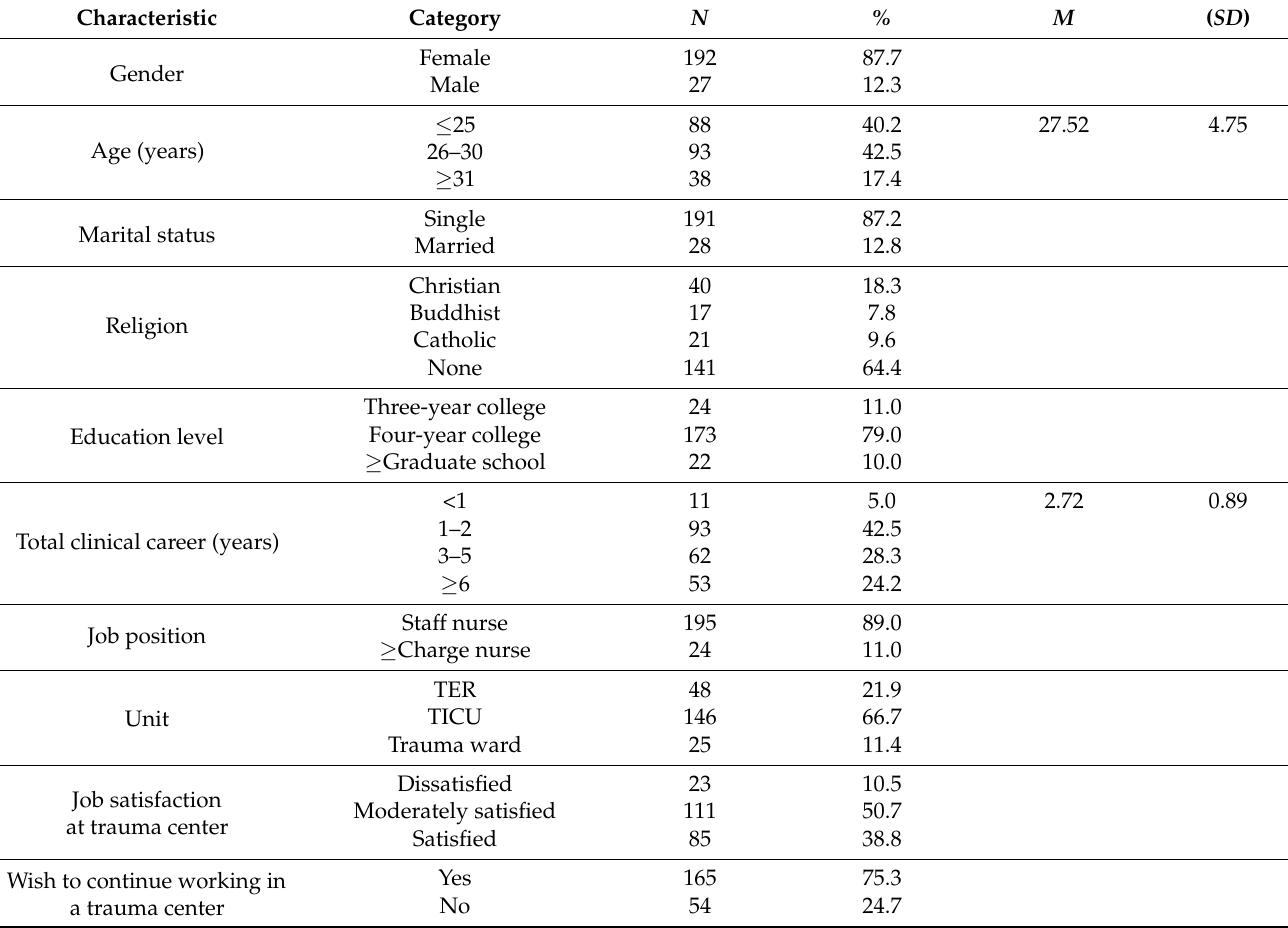
Table 1. Participants’ general characteristics and work-related characteristics (N = 219).